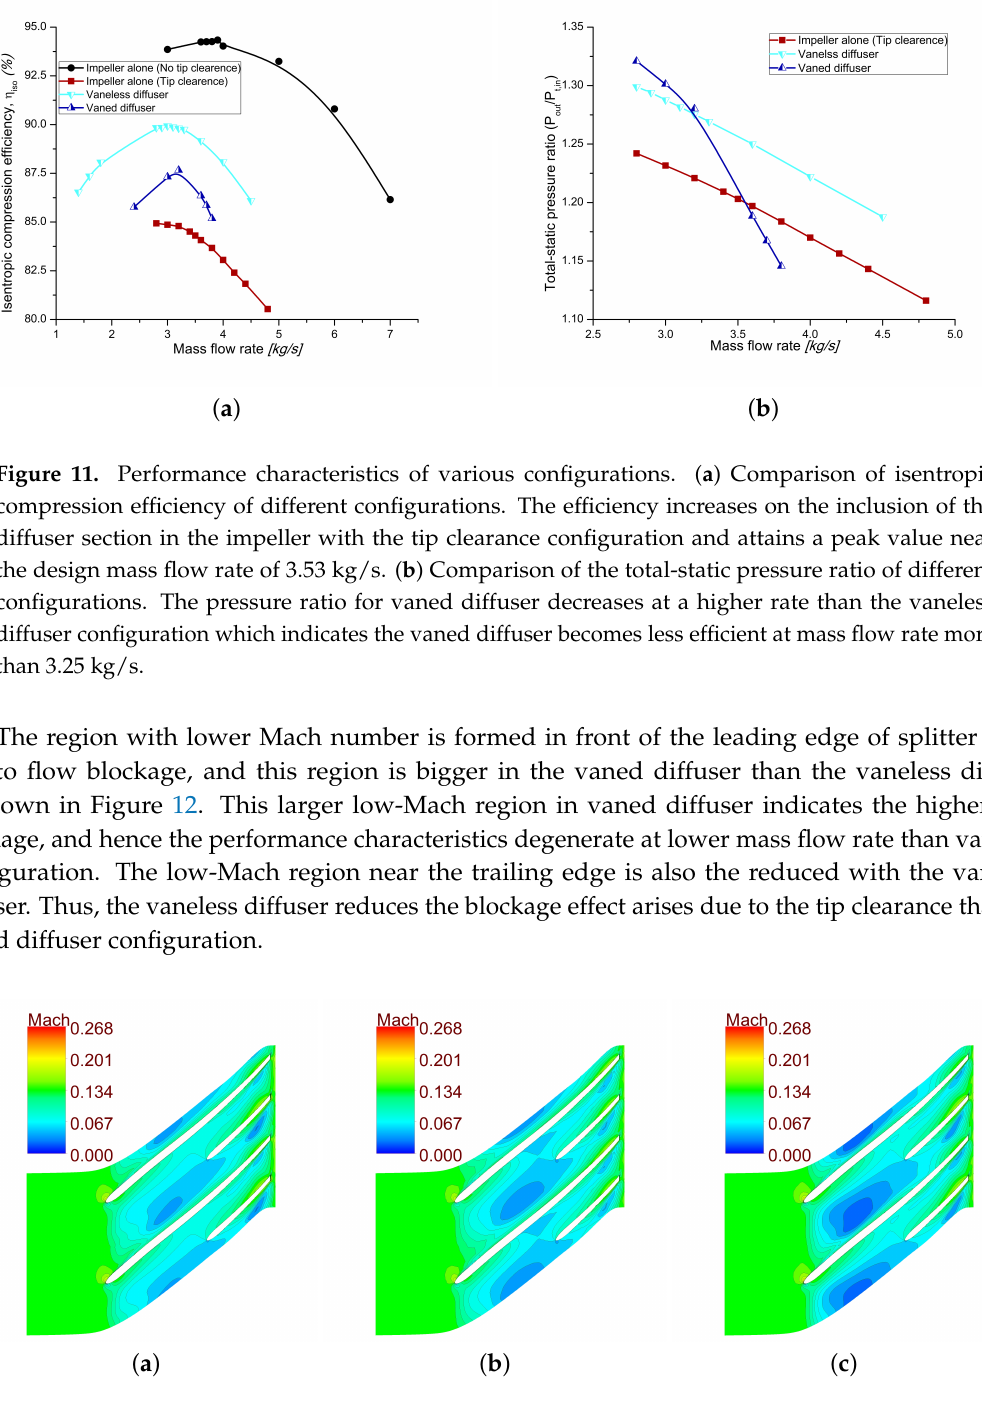
Figure 12. Relative Mach number contour plot at the span of 80% from hub to shroud at a mass flow rate of 3.2 kg/s. ( a ) Impeller alone. ( b ) Impeller with vaneless. ( c ) Impeller with